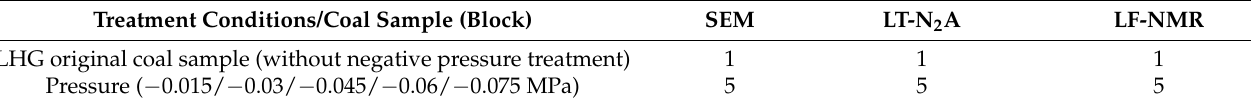
Table 2. Treatment conditions of negative pressure